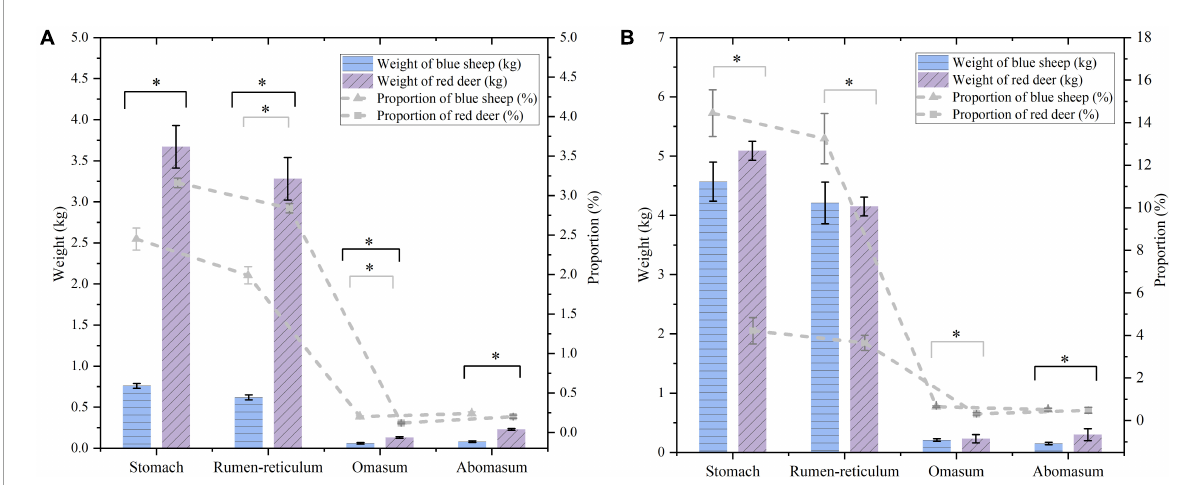
FIGURE4 (A) The stomach tissue weight and the proportion of stomach weight to the bodyweight of sympatric blue sheep and red deer (B) the stomach weight (contents included) and the proportion of stomach weight (contents included) to the bodyweight of sympatric blue sheep and red deer (the black and gray error bars represent the standard deviations of the weight and proportion, respectively). ∗ Means there is significant difference between blue sheep and red deer.